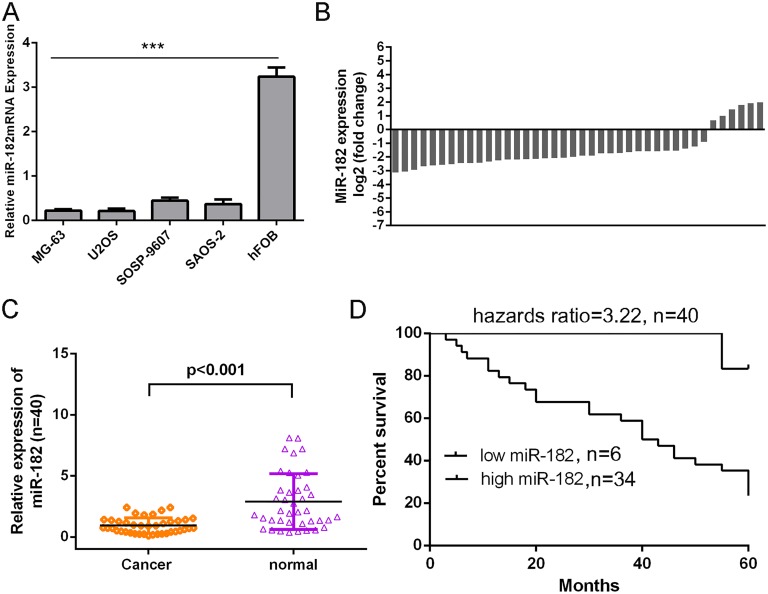
miR-182 was down-regulated in osteosarcoma cell lines and tissues.(A) The expression levels of miR-182 were measured by qRT-PCR in osteosarcoma cell lines (U2OS, MG-63, SOSP-9607, and SAOS-2) and human normal osteoblastic cell line (hFOB). The expression of miR-182 was down-regulated in osteosarcoma cell lines. (B) Relative expression of miR-182 in 40 primary osteosarcoma tissues compared with their pair-matched nontumor tissues. Data are shown as log2 of relative ratio change of osteosarcoma tissues relative to normal tissues. (C) The expression of miR-182 in the human osteosarcoma tissues was lower than that in non-tumor adjacent tissues. (D) Loss of miR-182 levels in patients with osteosarcoma was associated with considerably shortened disease-free survival. All data were normalized by U6 snRNA. ***p<0.001.